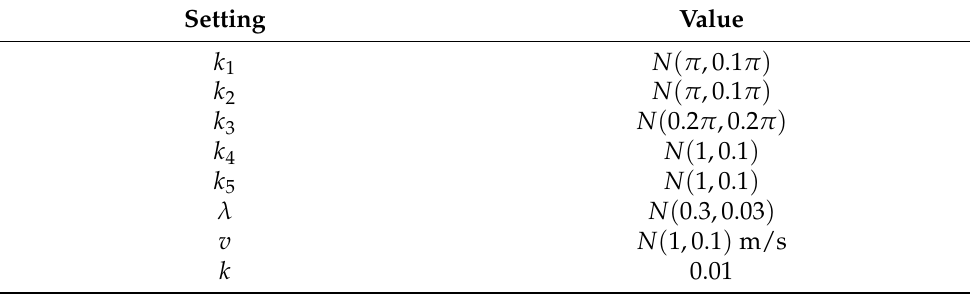
Figure 3. Node motion trajectory under Euler model. Table 2. Parameters